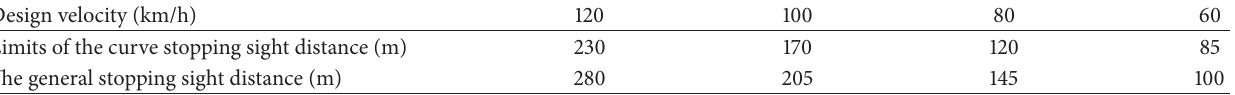
Table 3: Curve stopping sight